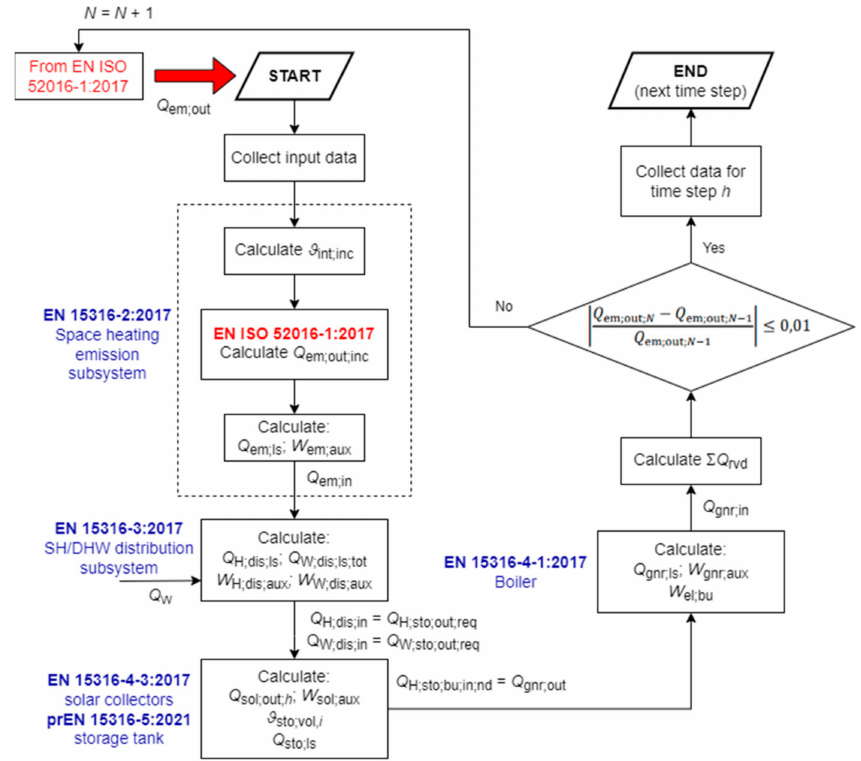
Figure 2. Diagram for the hourly calculation of a solar hot water system used for space heating and domestic hot water preparation, according to EN 15316 series of